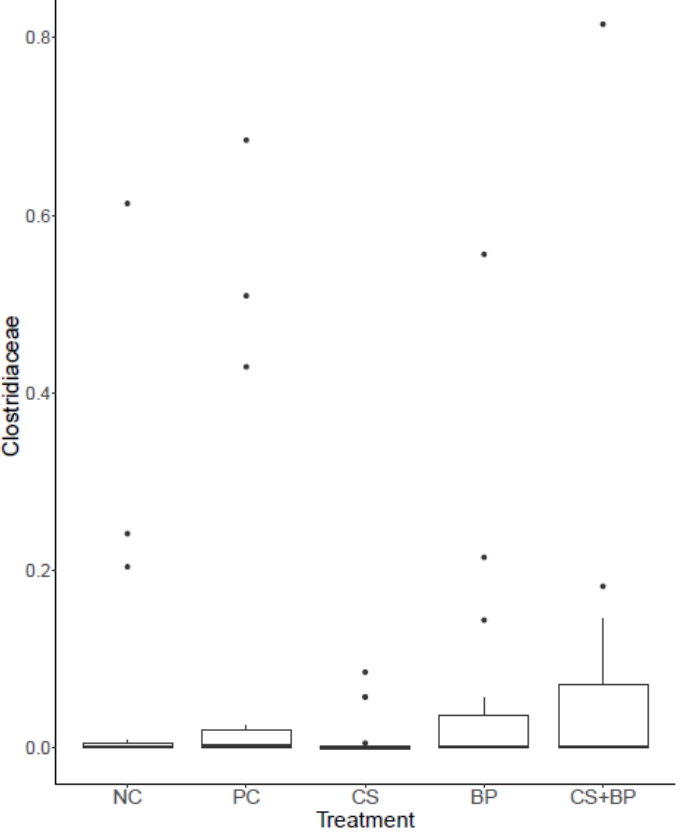
Figure 2. The distribution of Family Clostridiaceae in five different groups of broilers.